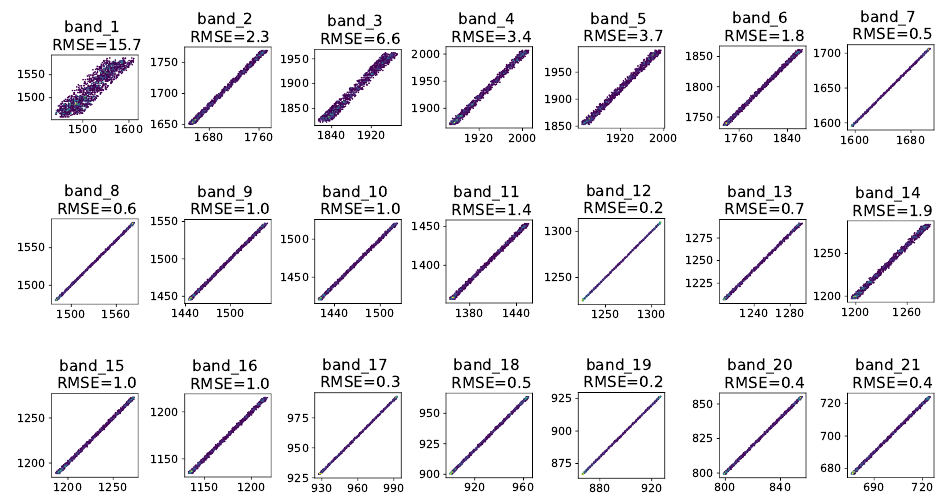
Figure 9. Comparison of the estimated ( y -axis) and in-product ( x -axis) extraterrestrial (top of atmo- sphere) solar flux, all in W m − 2 sr − 1 µ m − 1